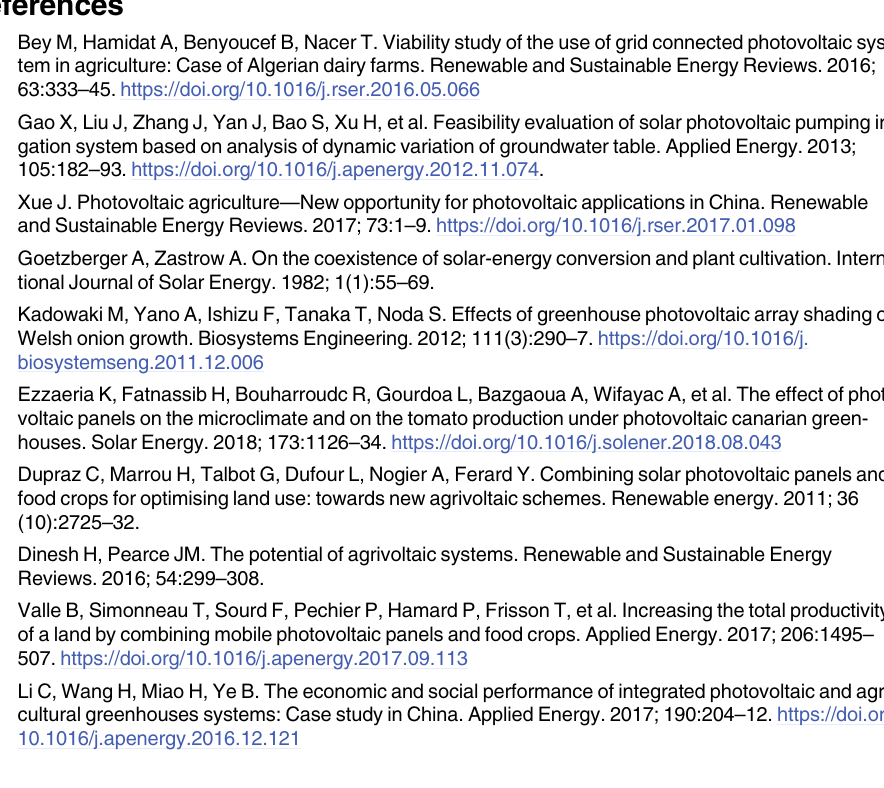
S6 Table. The raw data of the crop quality of lettuce (soluble protein, soluble sugar, vita- min C, and nitrate) in different